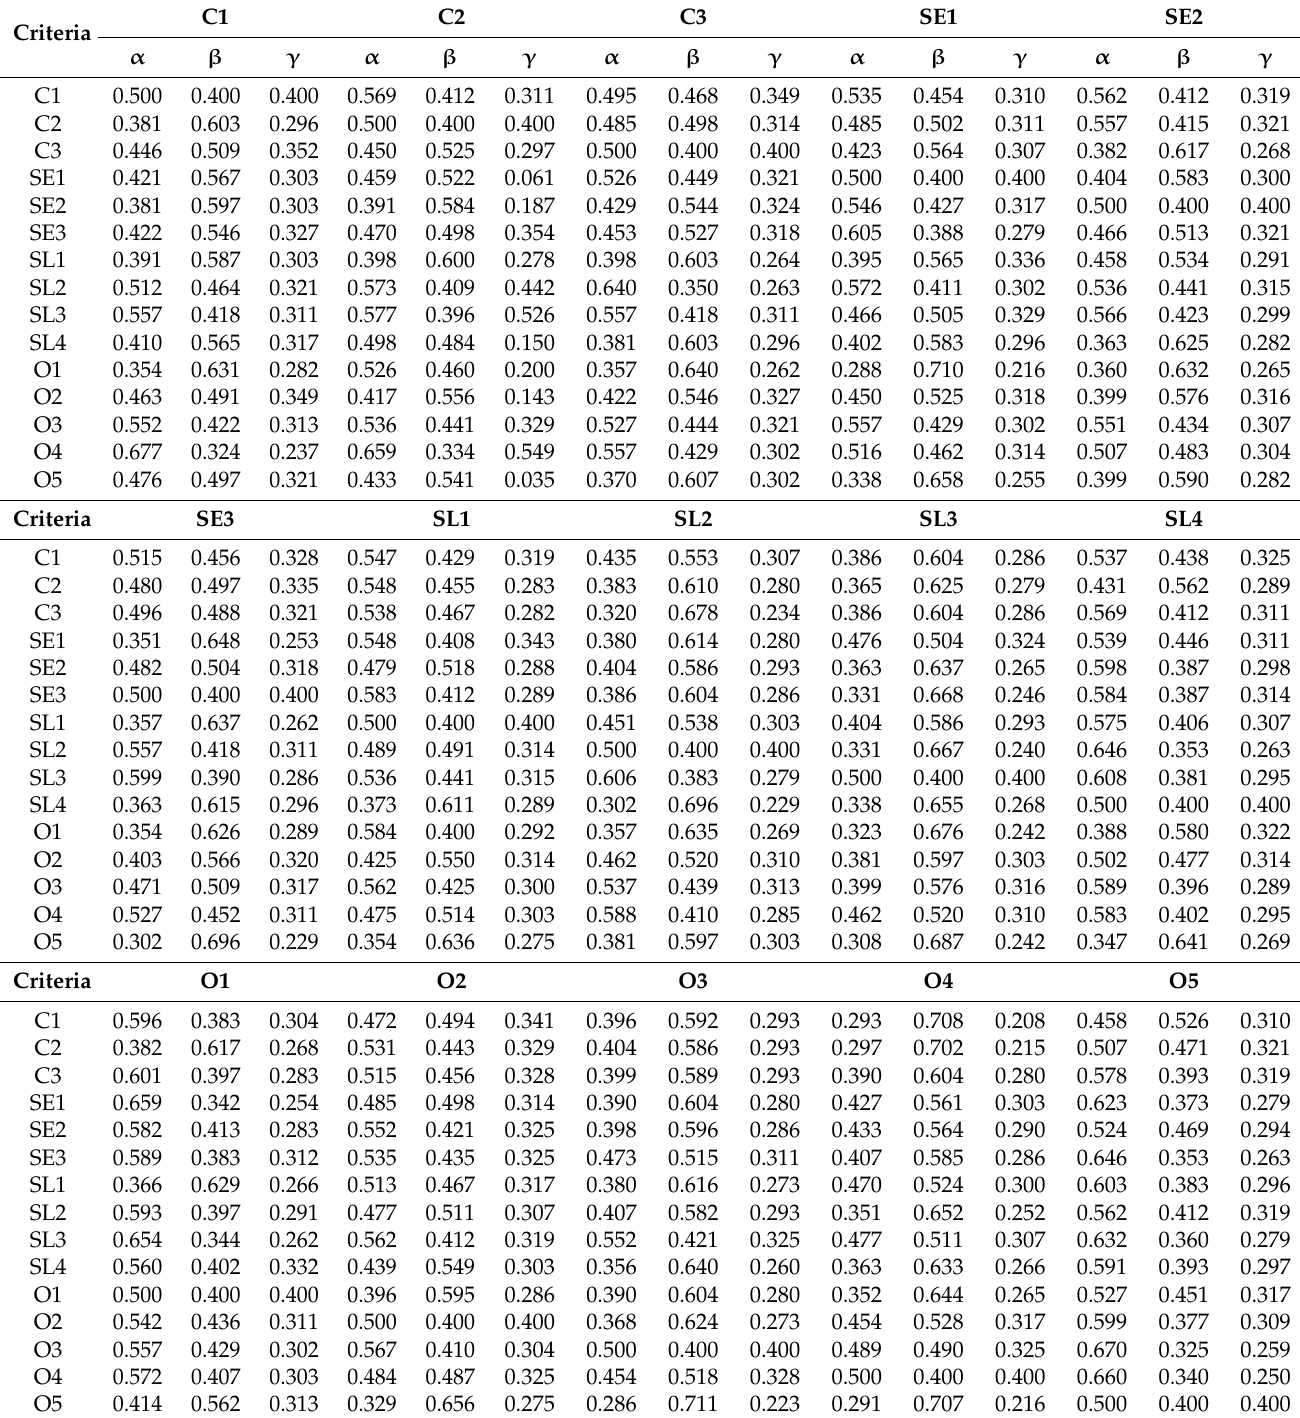
Table A1. The integrated spherical fuzzy comparison matrix of the SF-AHP